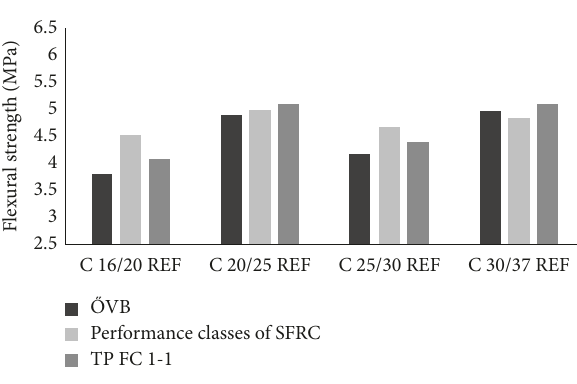
Figure 2: Bending strength of reference concrete mixtures.